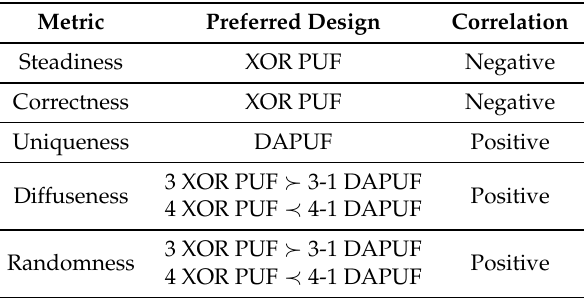
Table 5. Summary of preferred